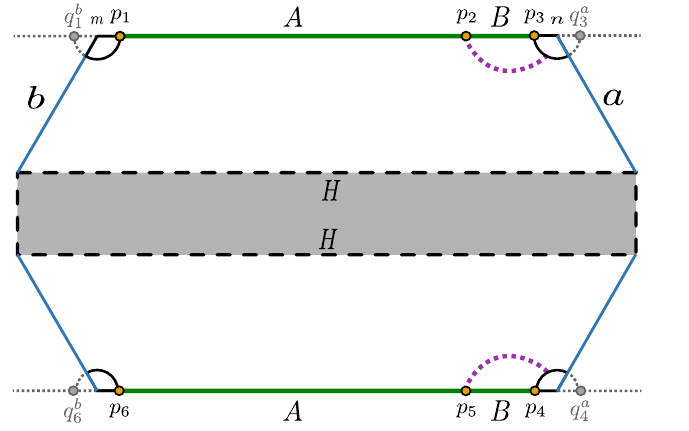
Figure 7 . Possible channel for S R . The violet dotted curve denotes the EWCS. All the points in the boundary theory are identified similarly as in figure